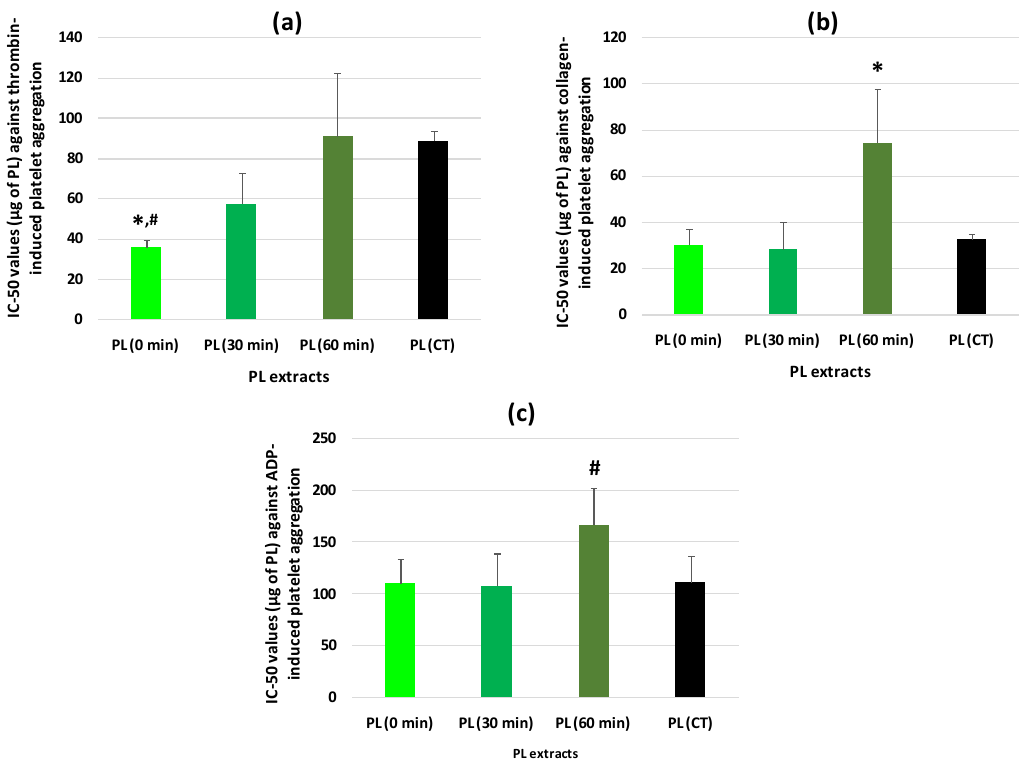
Figure 2. Antithrombotic effects of PL extracts from tea leaf samples, before (0 min) and after 30 and 60 min of oxidation, against thrombin ( a ), collagen ( b ), and ADP ( c ) induced aggregation of human platelets, in comparison to those of CT. Results are expressed as IC 50 (half-maximal inhibitory concentration) values that reflect the inhibitory strength of each PL extract against thrombin, collagen, and ADP-induced platelet aggregation and is expressed as mean values of µg of PL in the aggregometer cuvette that causes 50% of inhibition on thrombin, collagen, and ADP-induced aggregation of platelets in hPRP ± SD. * Indicates statistical significant differences ( p < 0.05); # indicates borderline statistical differences (0.05 < p < 0.10); PL: Polar lipids; CT: Commercial tea samples; ADP: Adenosine-5'-diphosphate; hPRP: Human platelet-rich plasma; SD: Standard deviation.